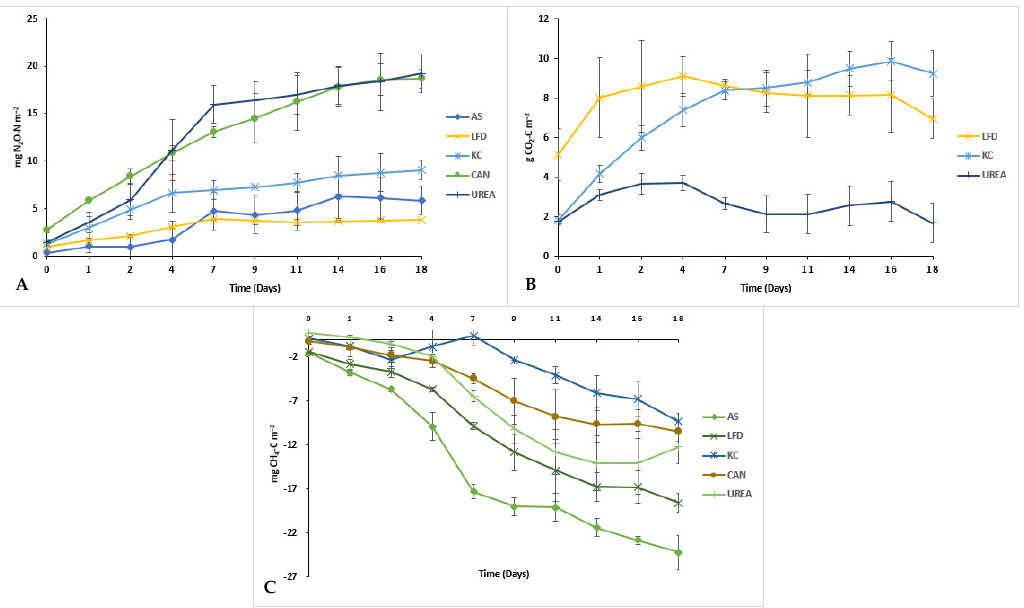
Figure 4. Cumulative emissions of nitrous oxide (mg N 2 O-N per m 2 of soil) ( A ), carbon dioxide (g CO 2 -C per m 2 of soil) ( B ), and methane (mg CH 4 -C per m 2 of soil) ( C ) emissions measured during incubation of digestate-derived organic fertilisers. Legend: AS—ammonium sulphate, LFD—liquid fraction of digestate, KC—potassium concentrate, and CAN—calcium ammonium nitrate. Table 5. Emission factors of nitrous oxide (N 2 O), carbon dioxide (CO 2 ), and methane (CH 4 ) ex- pressed per 100 g of N applied for tested bio-based fertilisers and mineral N fertilisers. Fertiliser Type